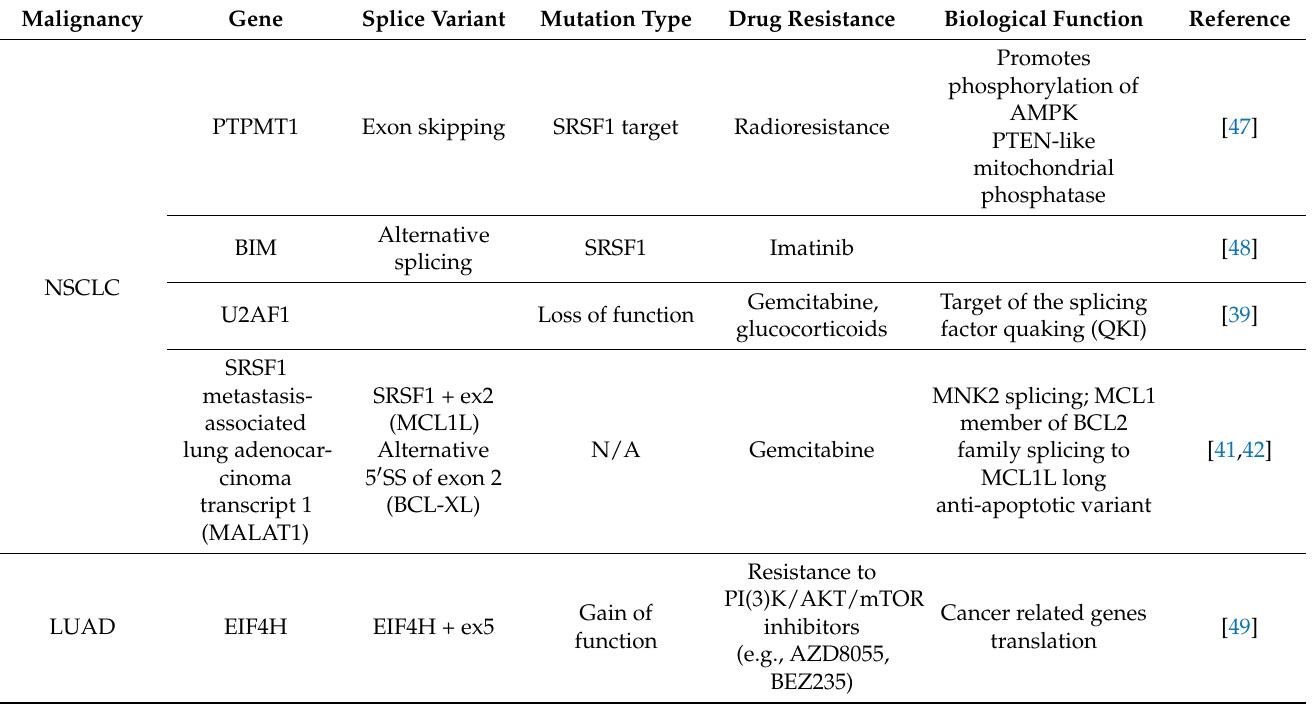
Table 1. AS and effects on drug resistance in lung